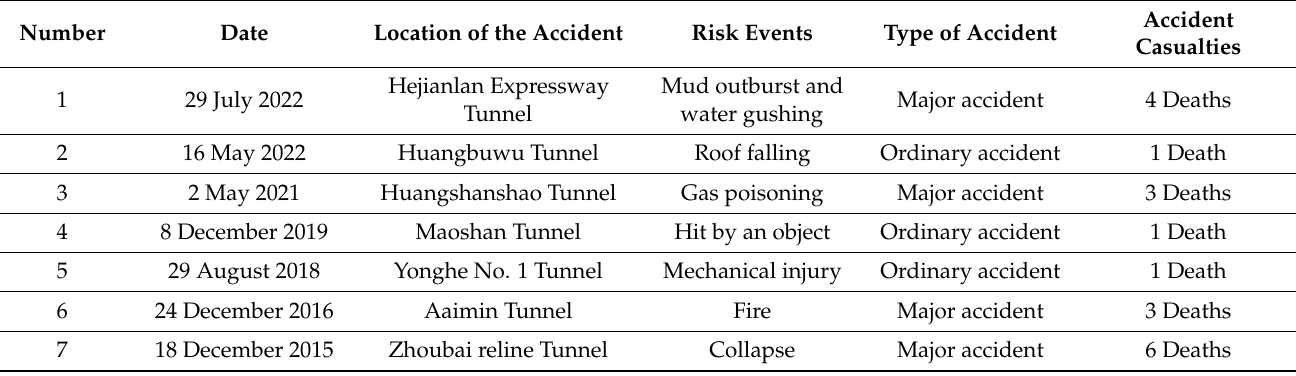
Table 2. Excerpts of tunnel construction safety accident cases,